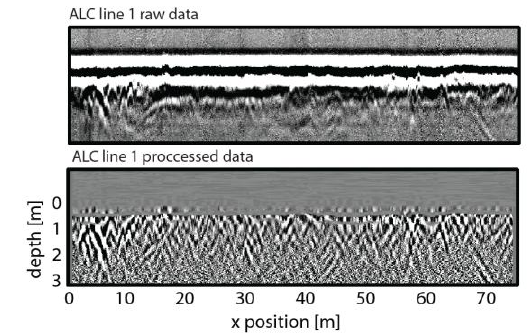
Figure 9. ( top ) example of raw GPR data; ( bottom ) after